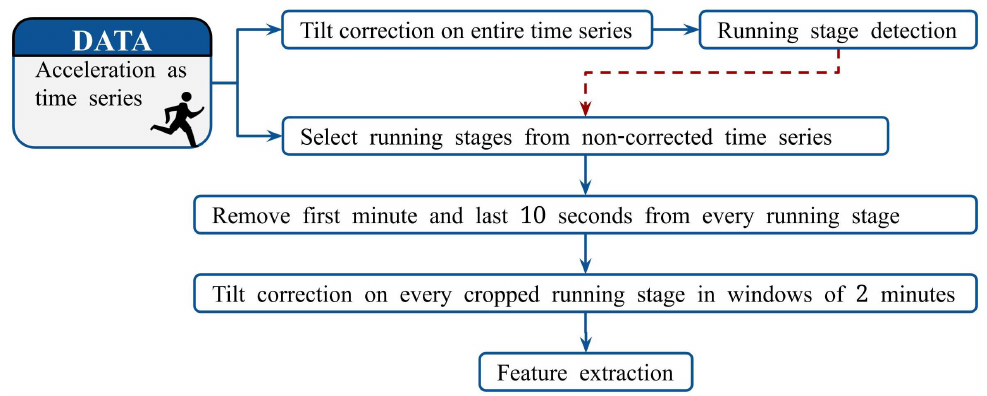
Figure 1. Diagram of the preprocessing procedure of the data. A blue arrow indicates the flow of data. The red dashed arrow denotes the flow of information about the location of the running stages within the entire time